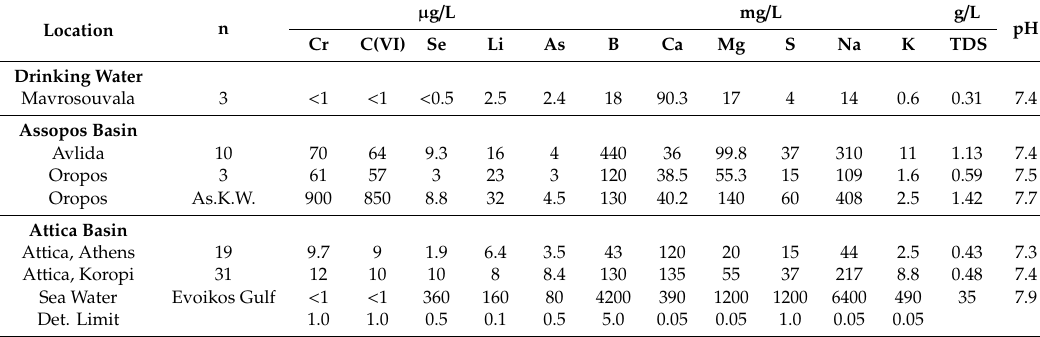
Table 5. Average composition of groundwater from the Assopos-Thiva and Attica basins [17–23,33]. Location